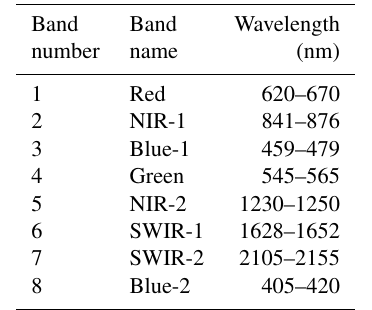
Table 1. MODIS spectral bands. NIR is for near-infrared, and SWIR is for shortwave